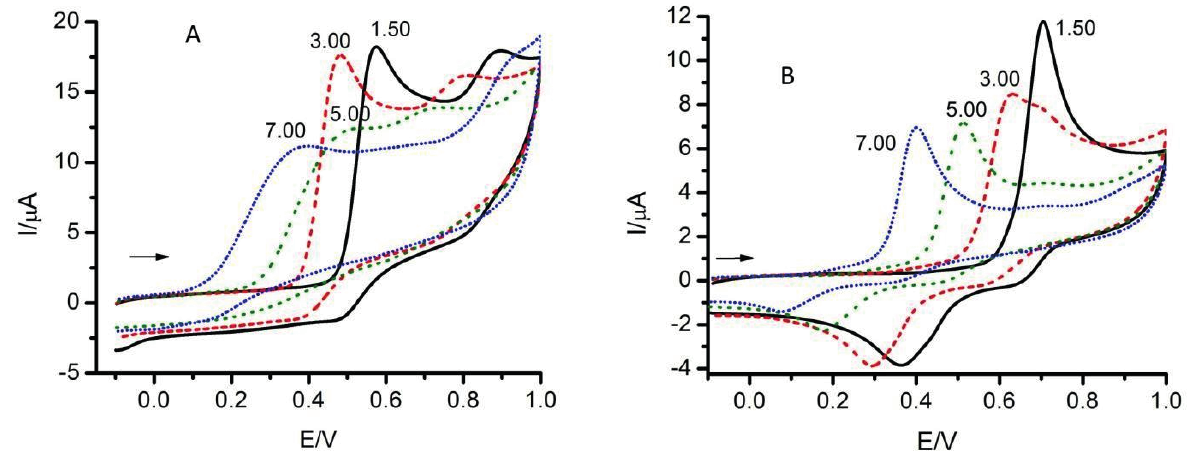
Figure 2: Cyclic voltammograms of gallic acid (A) and eugenol (B); arrows indicate the initial scan direction; experimental conditions: v = 0.1 V s −1 , c = 5 × 10 −4 M and different pH values comprised between 1.50 and 7.0